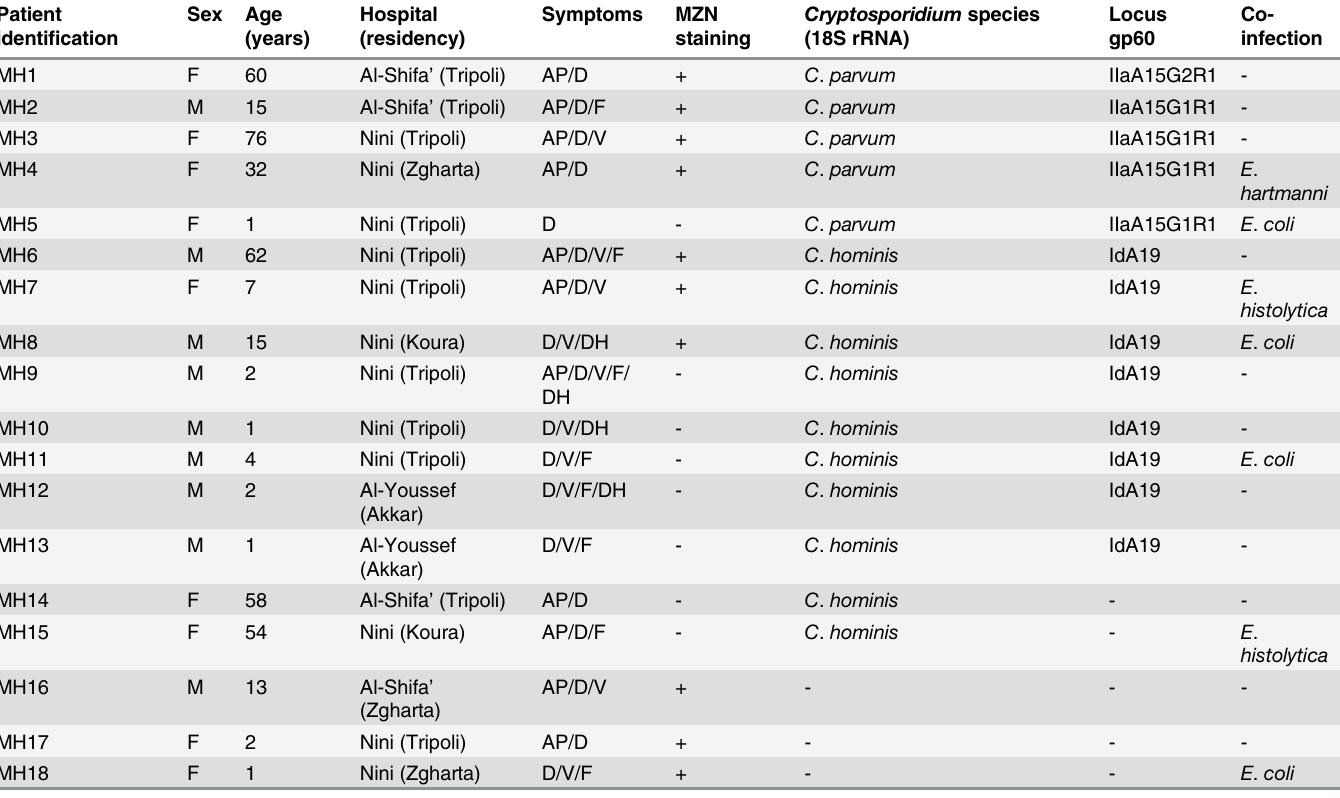
Table 1. Clinical data and Cryptosporidium spp. and genotypes among symptomatic patients in Lebanon. Patient identi fi